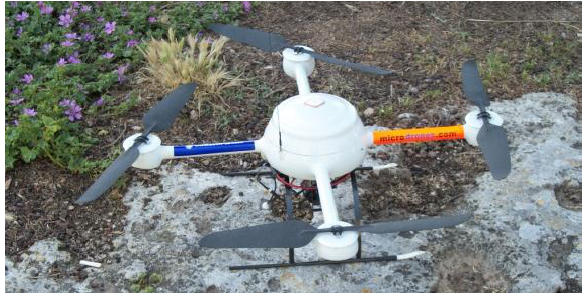
Figure 6. The Zenith